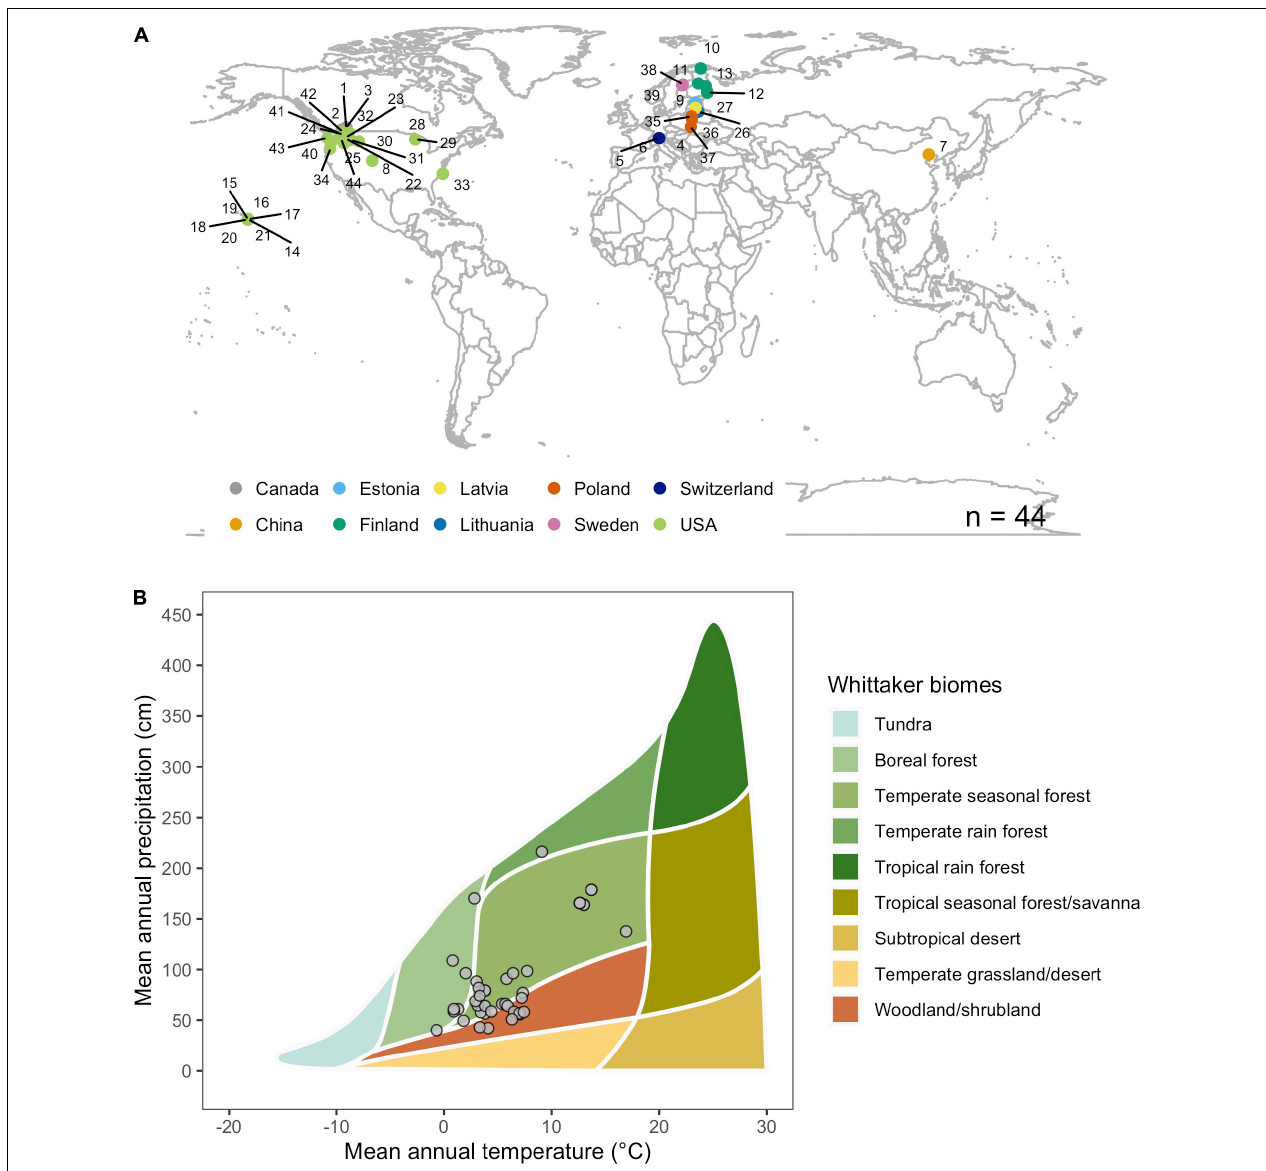
FIGURE 1 | Geographic and climatic distribution of experimental sites. (A) Locations of the 44 sites at which our decomposition experiments were conducted. (B) The sites cover all major forest biomes with the exception of tropical rainforests and tropical seasonal forests/savannas. Mean annual temperature (MAT) and mean annual precipitation (MAP) values represent 30-year mean values between 1970 and 2020. Data was obtained from the Worldclim data base (www.worldclim.com). Additional site details can be found in Supplementary Tables 1, 2